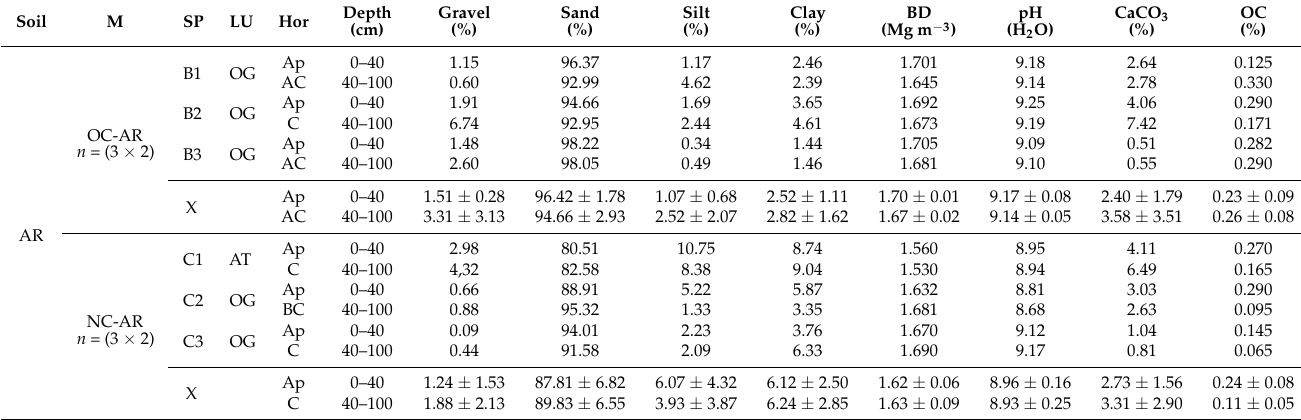
Table 4. Principal soil properties evaluated (average ± SD *) in the soil profile by soil control section in Arenosols. Soil